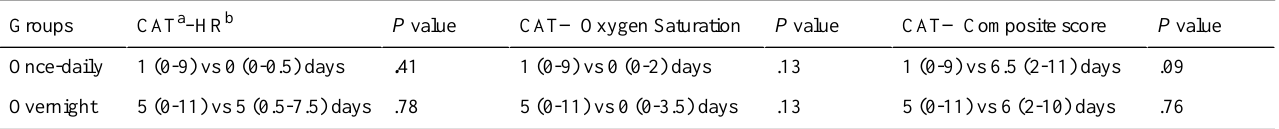
Table 3. Time difference to treatment initiation at exacerbation between symptoms and physiological variables first becoming abnormal.